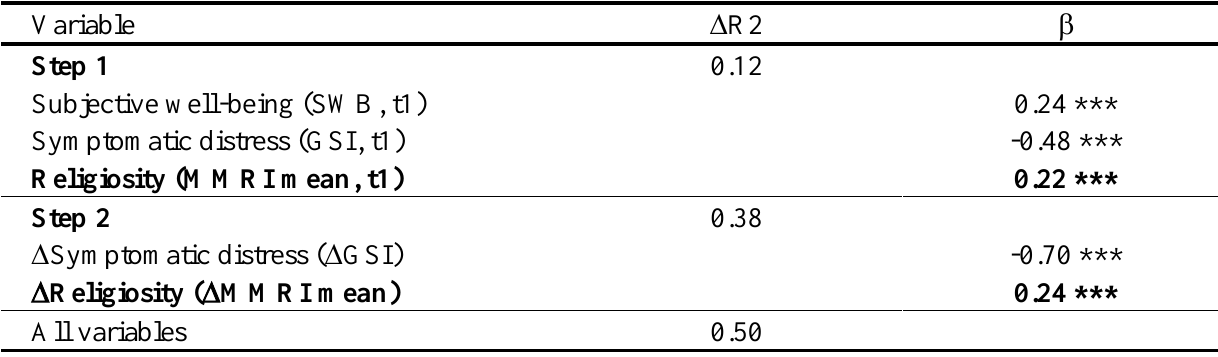
Table 5. Intrinsic religiosity predicting subjective well-being